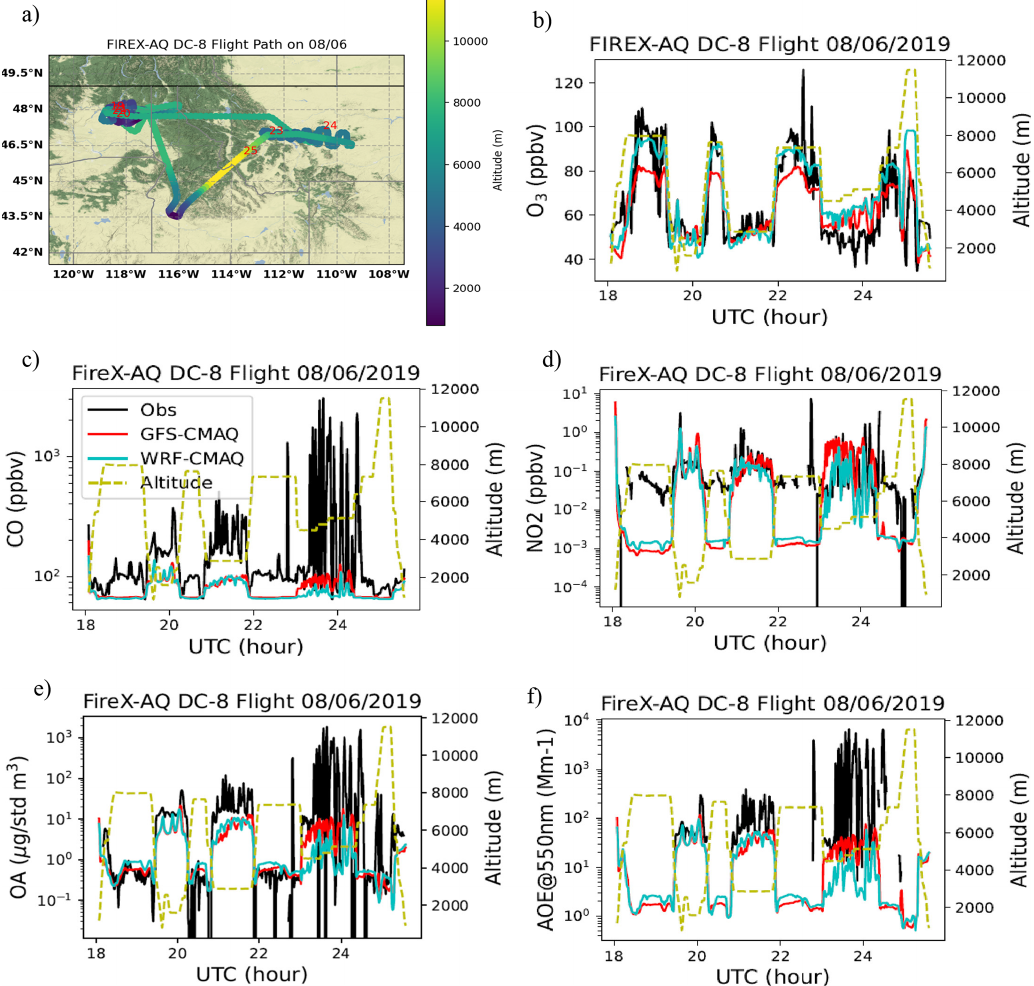
Figure 10. The DC-8 flight path (a) as well as model–observation comparisons for O 3 (b) , CO (c) , NO 2 (d) , submicron organic aerosol (OA) (e) and the aerosol optical extinction coefficient (AOE) at a wavelength of 550nm (f) on 6 August 2019. Base map credits: © Open- StreetMap contributors 2022. Distributed under the Open Data Commons Open Database License (ODbL)